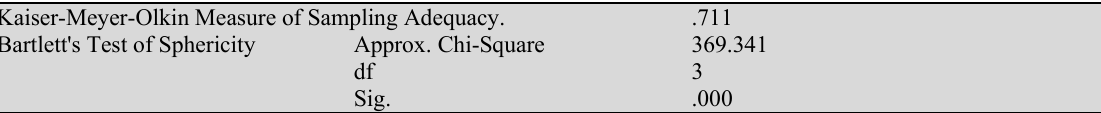
The results of total variance explained Component